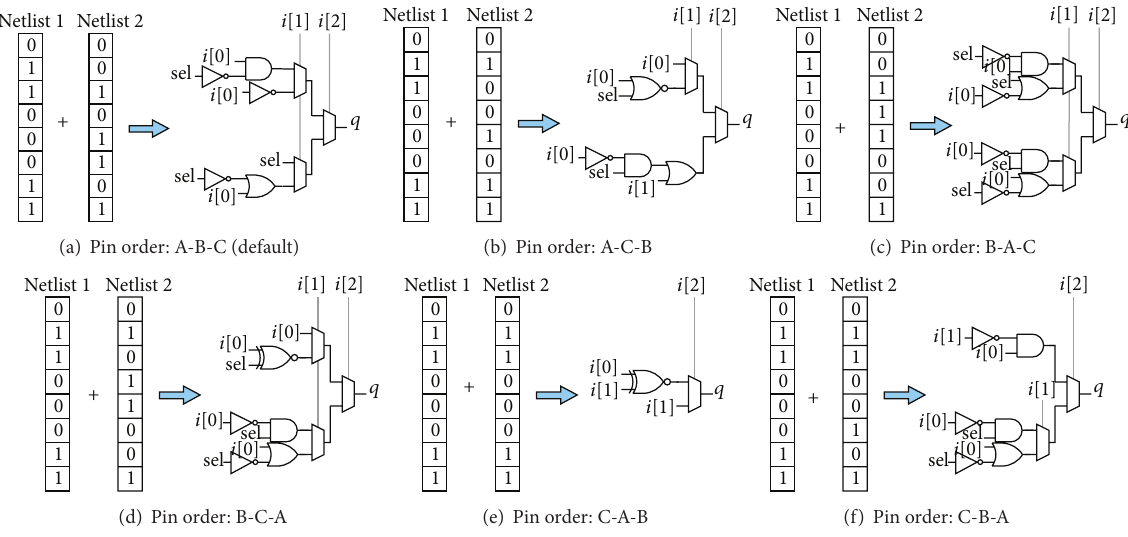
Figure 12: LUT input pin reordering